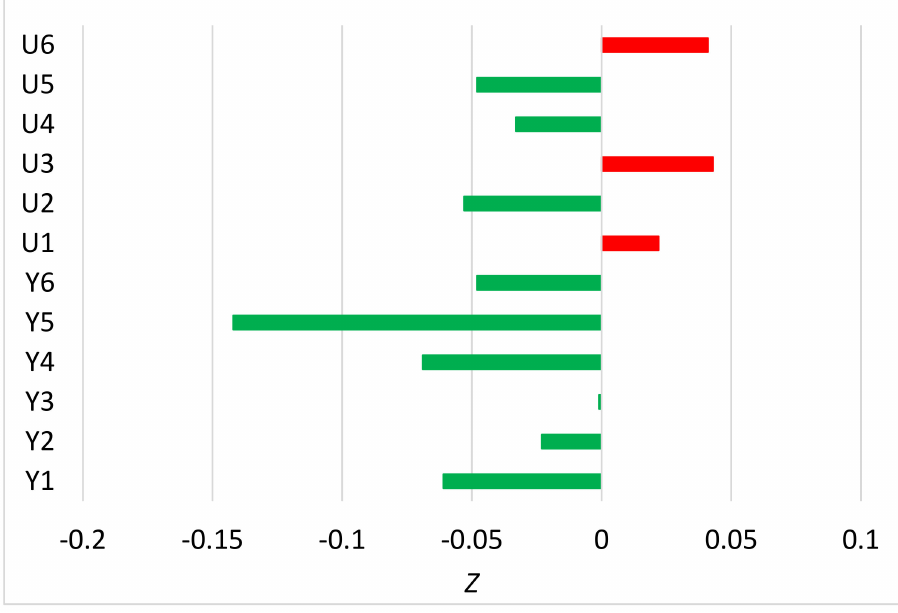
Figure 4. The same as Figure 1, but for the mean absolute network mean trend